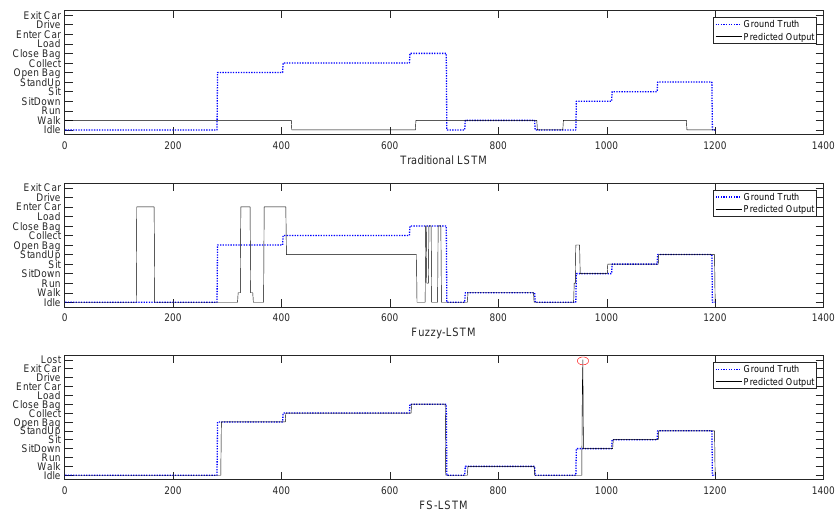
Figure 11. The benchmark of three predicted output sequences via Traditional LSTM, Fuzzy-LSTM and FS-LSTM. The Lost state is marked with the red circle.